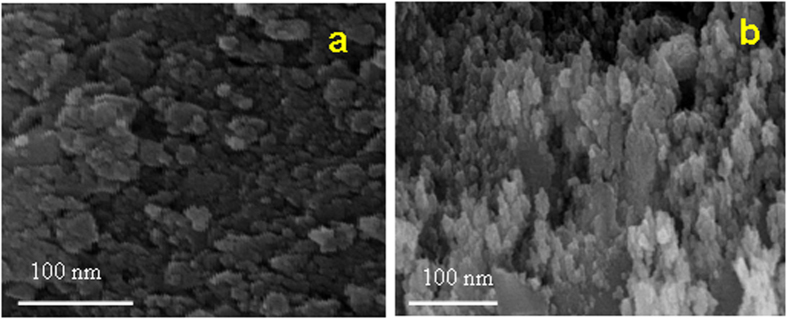
SEM images of (a) CeO2 NPs prepared by the MCM and (b) CeO2 NPs prepared by CRGSM.